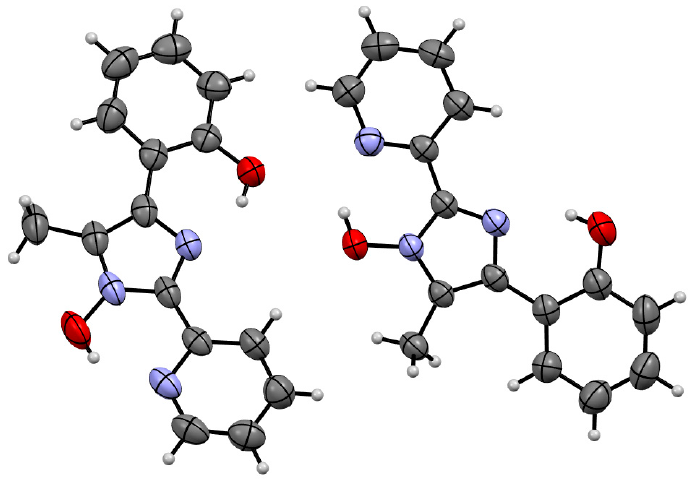
Figure 1. Two crystallographically independent molecules in the structure of L OH,OH .